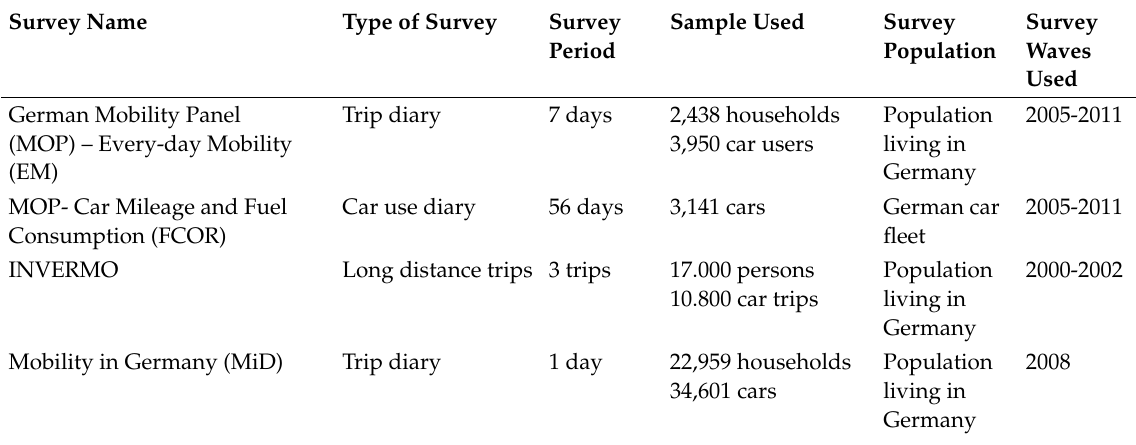
Table 1. Travel surveys used as input for CUMILE (see Streit et al. (2015); Zumkeller et al. (2006); Zumkeller and Chlond (2009); infas and DLR (2010))